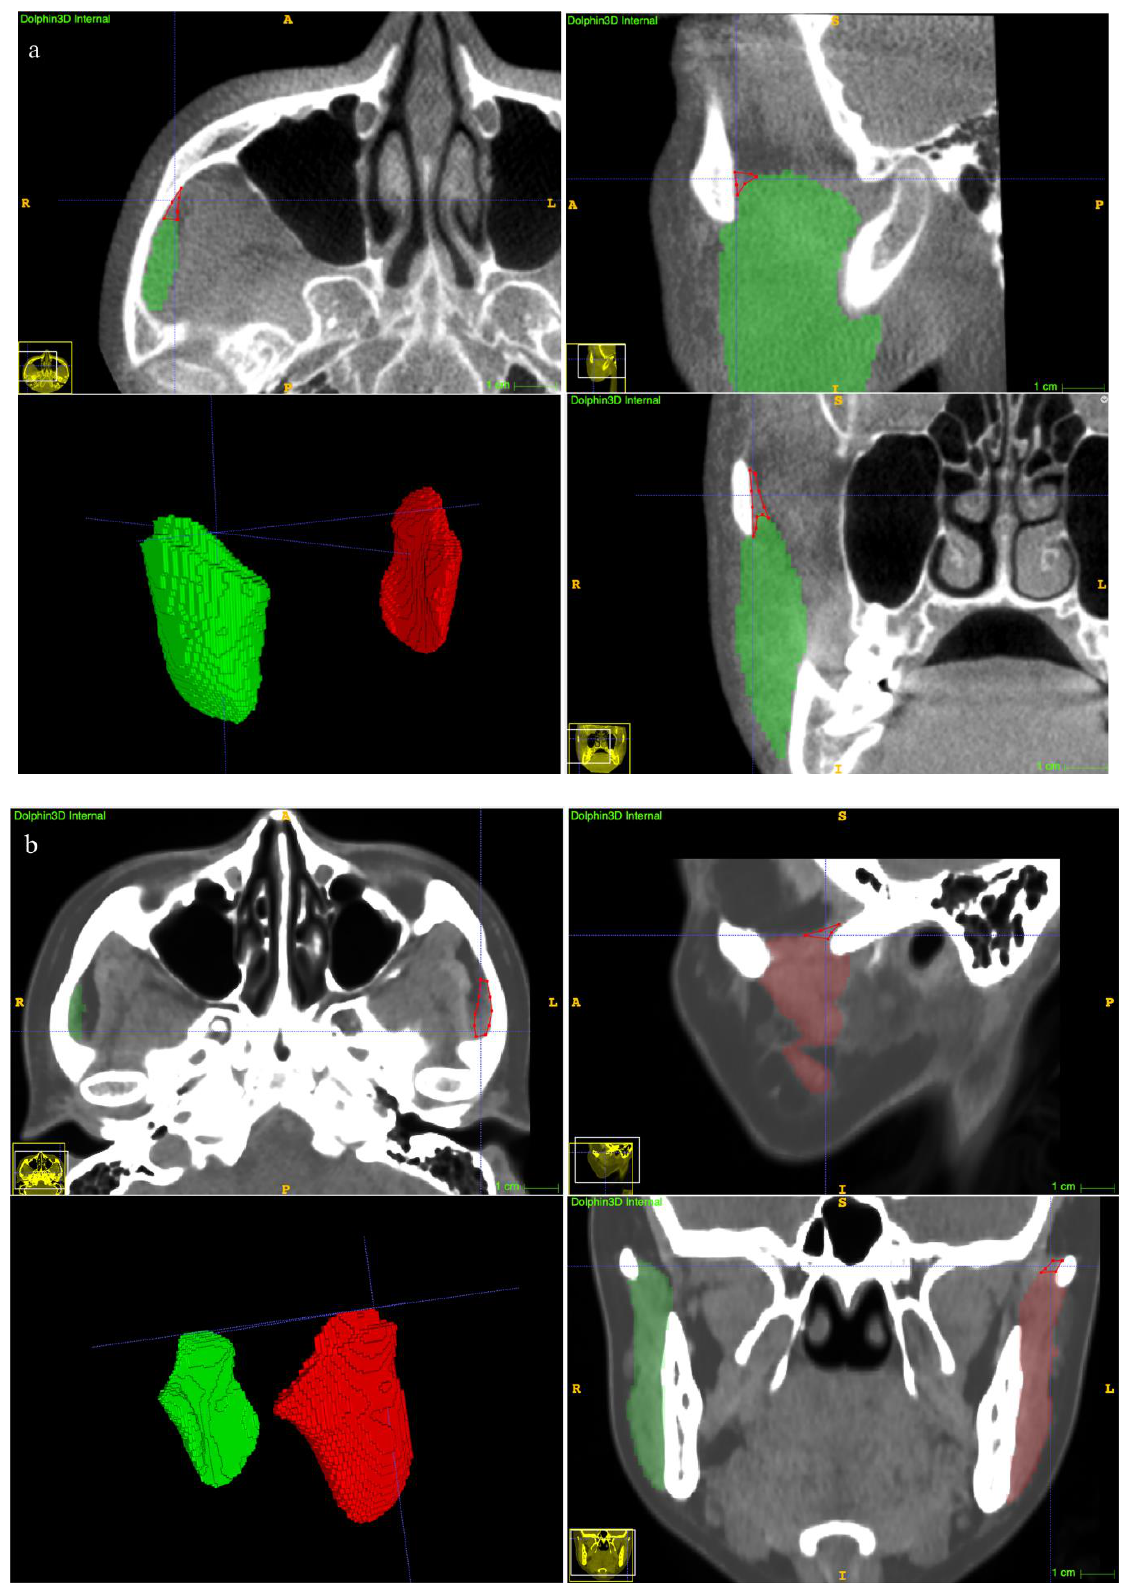
Figure 7. Examples of undersegmentation of the automatic model on the superior extent of the MM. The red polygon shows the undersegmented area. ( a ) CBCT segmentation results. ( b ) CT segmentation results.